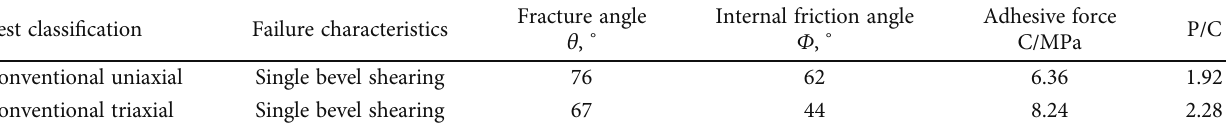
Table 2: The Mechanical parameters of conventional uniaxial (triaxial) compression failure.